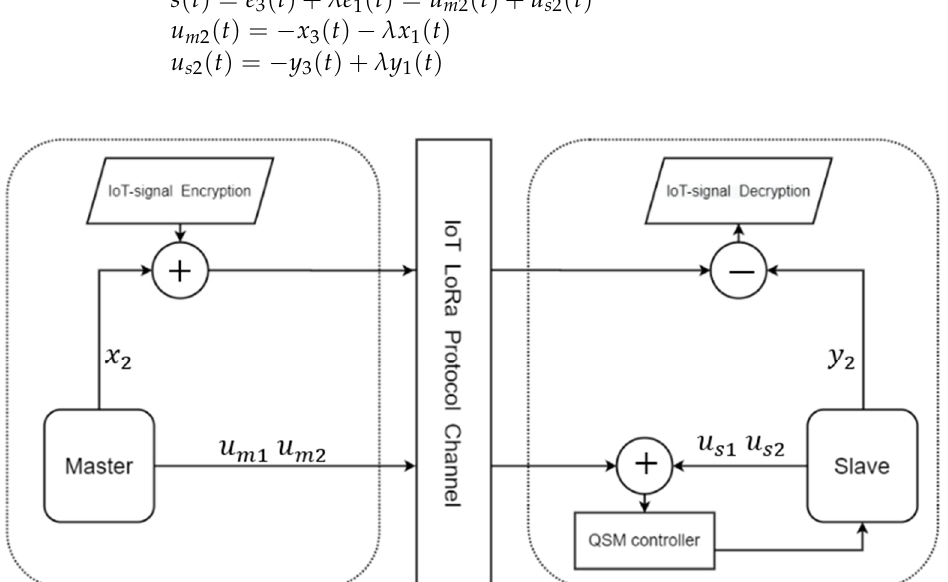
Figure 12. The secure IoT signal system architecture (QSM).